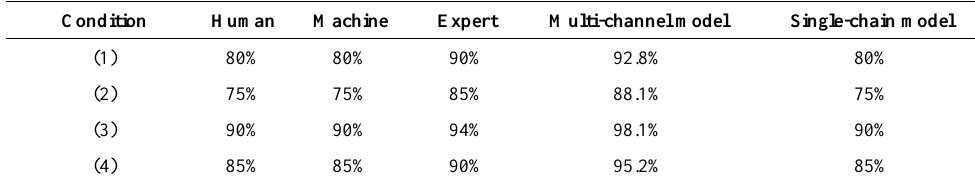
Table 2. Comparative accuracy, single chain vs. multi-channel hybrid models